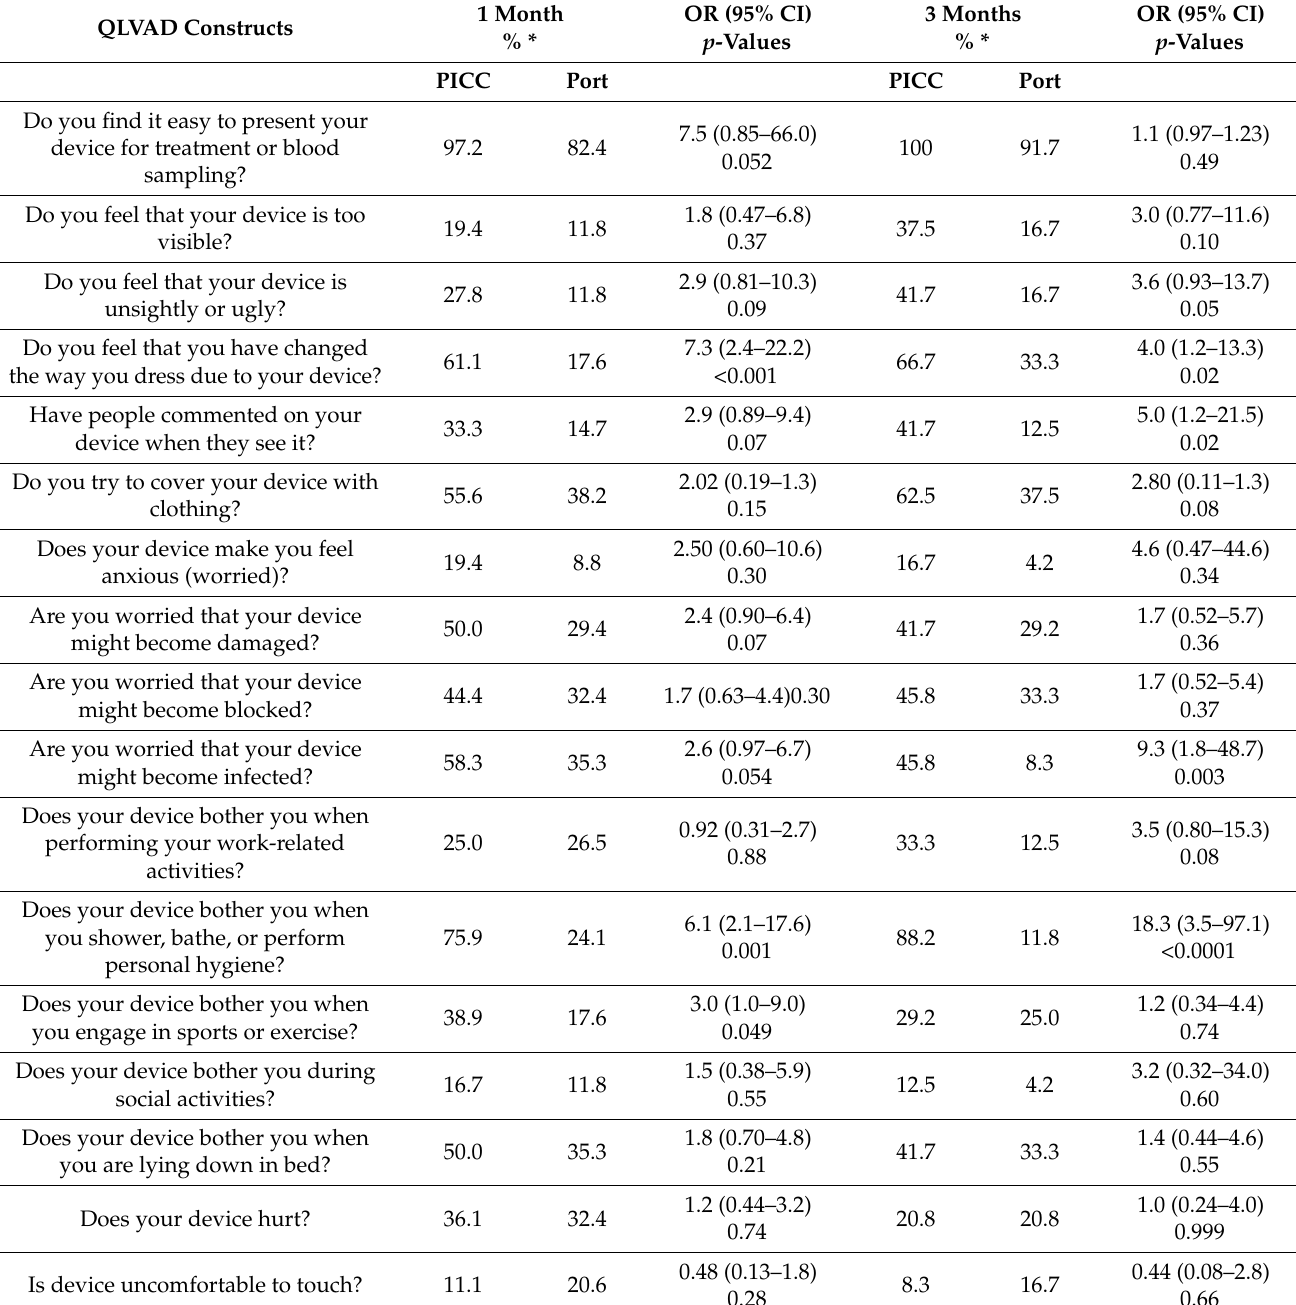
Table 3. Proportions, odds ratios, and 95% confidence intervals of various QLVAD scales at baseline and 3 months between the PICC line and the Port